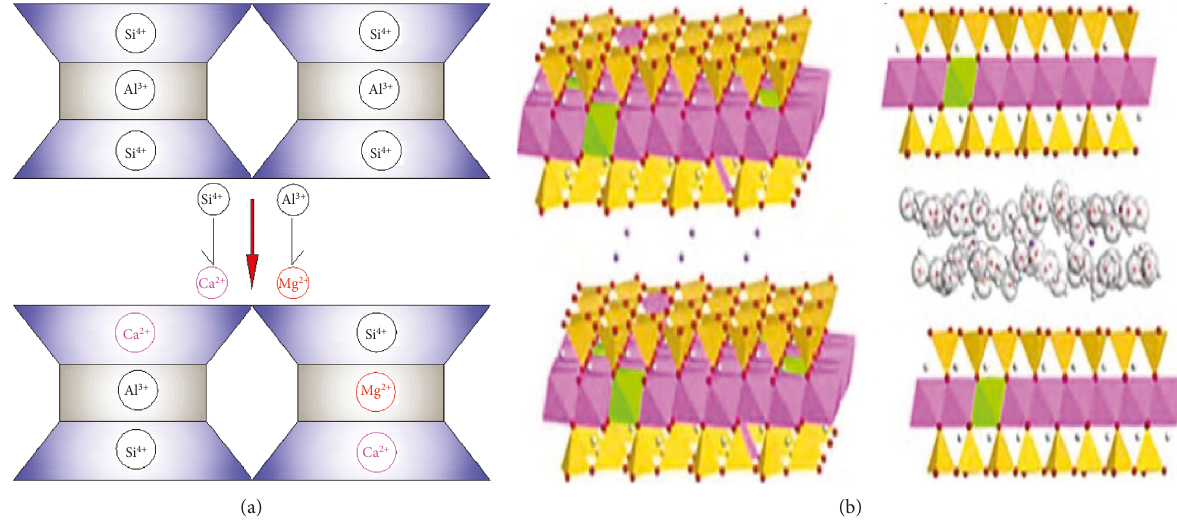
Figure 23: Schematic diagram of water absorption expansion in montmorillonite. (a) Ion exchange; (b) water absorption